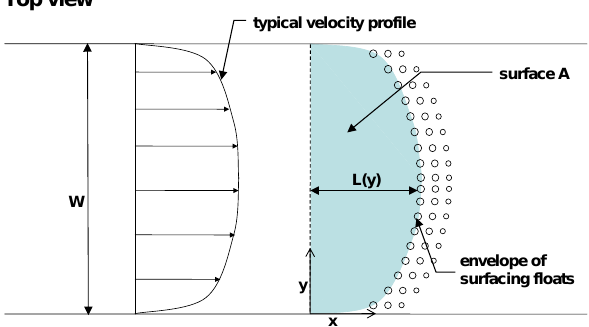
Fig. 3. Surface A between the float release line and the envelope of surfacing